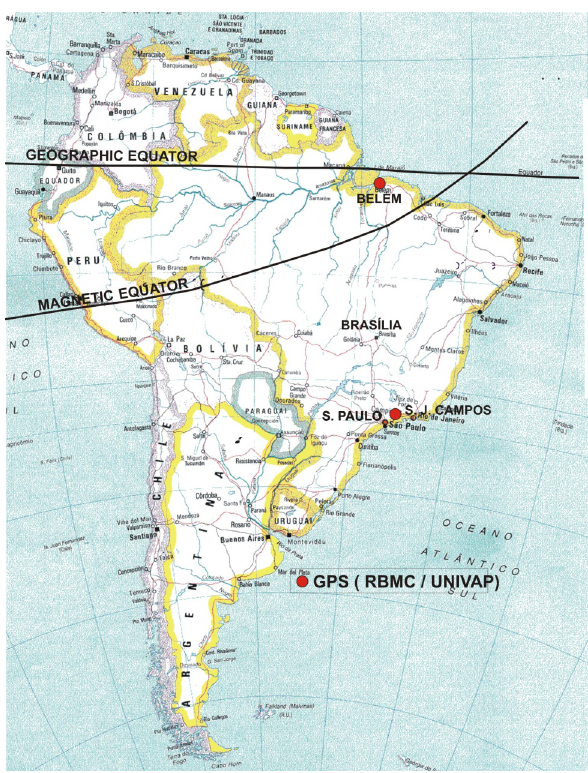
Figure 1: Map of the GPS ground facilities in the Brazilian cities of São José dos 436 Fig. 1. Map of the GPS ground facilities in the Brazilian cities of S˜ao Jos´e dos Campos and Bel´em. Campos and Belém. 437